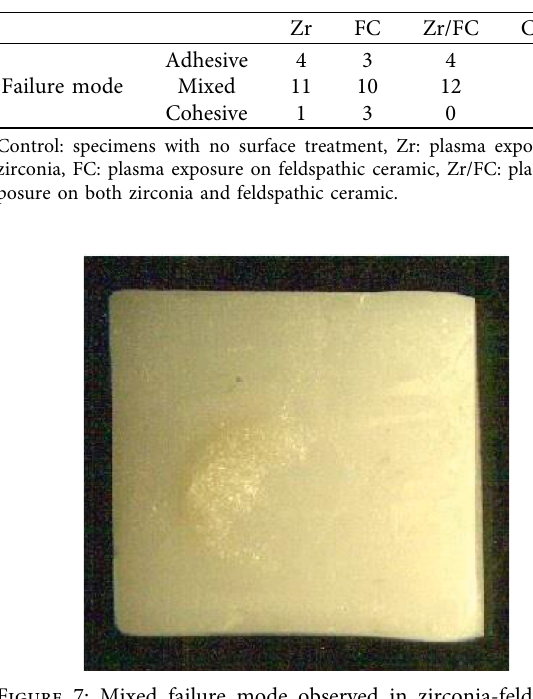
Table 2: The number of modes of failure observed in the exper- imental groups after shear bond test.